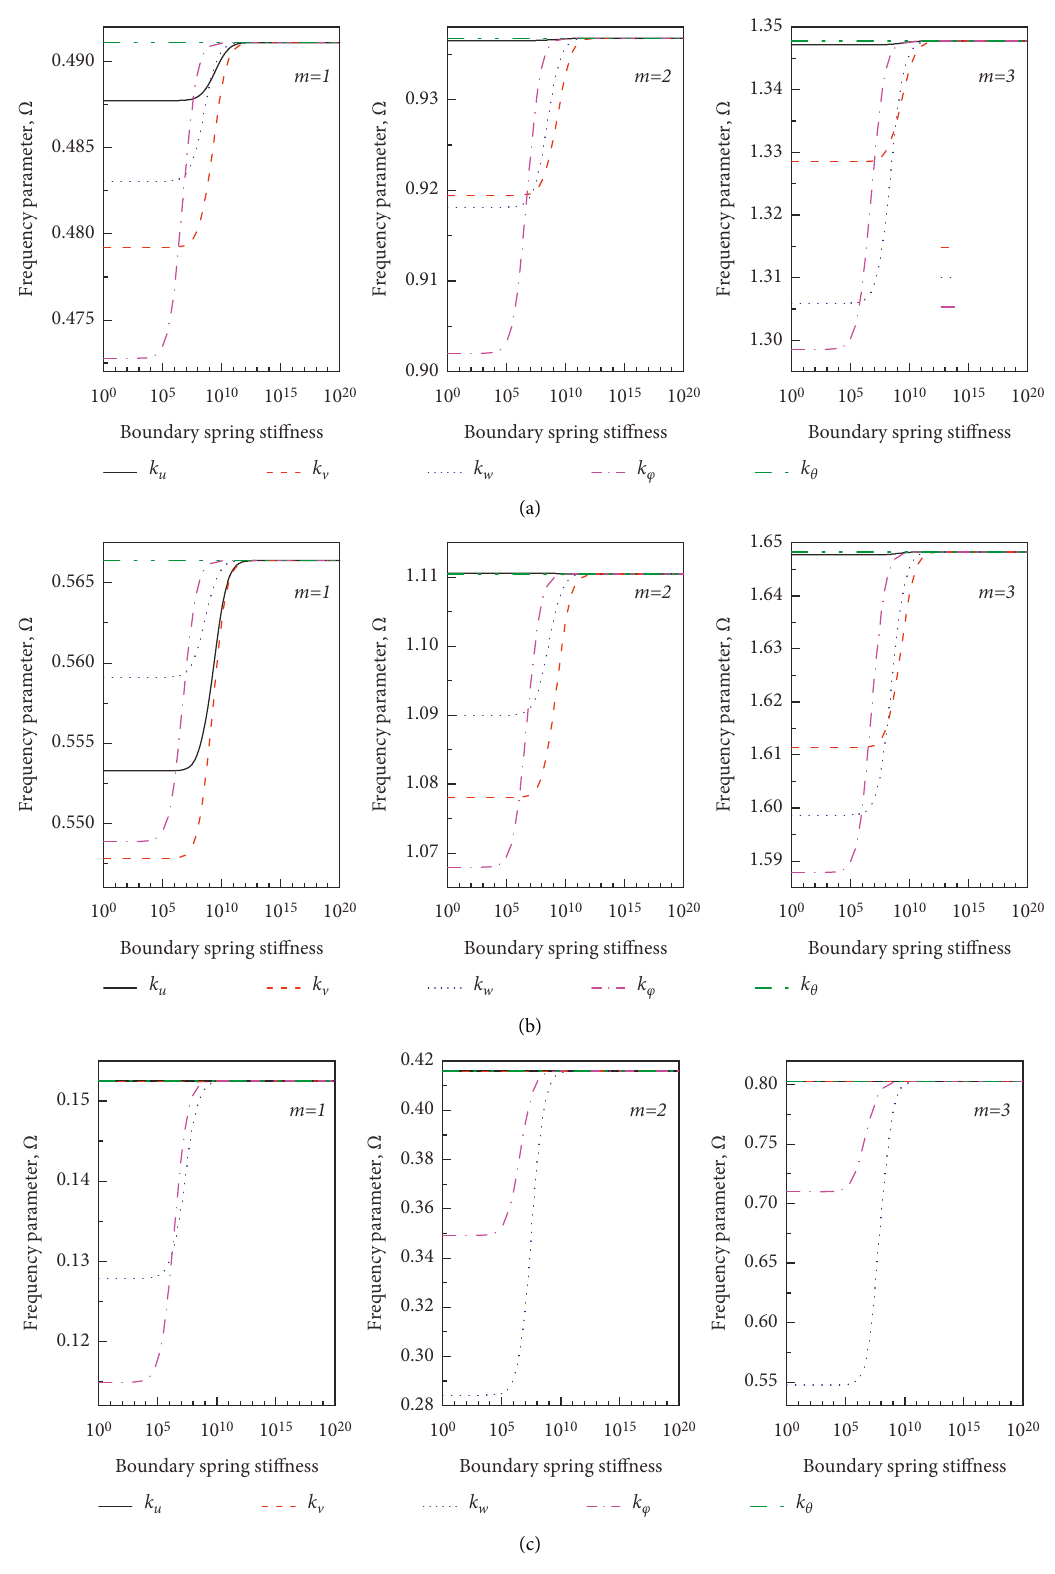
Figure 5: Variation of the frequency parameters Ω of laminated structures with variable thickness according to the boundary spring stiffness, (a) conical shell, (b) cylindrical shell, and (c) annular